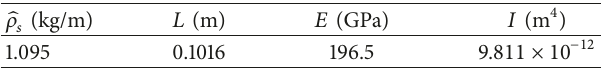
Table 3: Simulation and experimental parameters of the